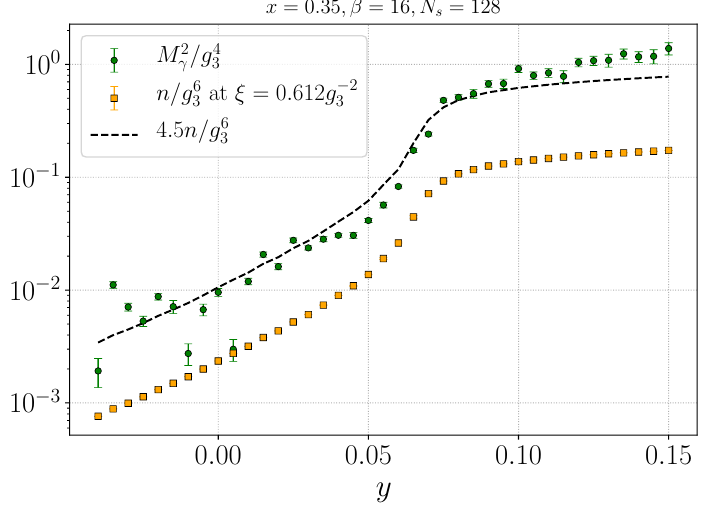
Figure 6 . Photon mass squared and the renormalized monopole number density, in appropriate units of g 2 , on the same log-scale. The dashed line illustrates approximate proportionality between 3 the